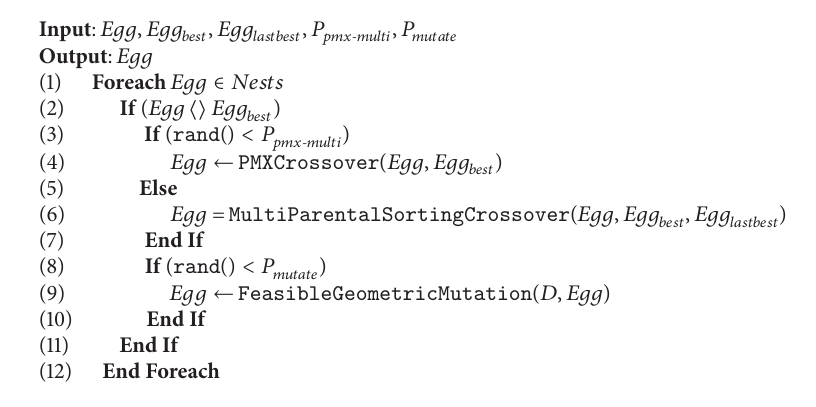
Algorithm 9: Geometric